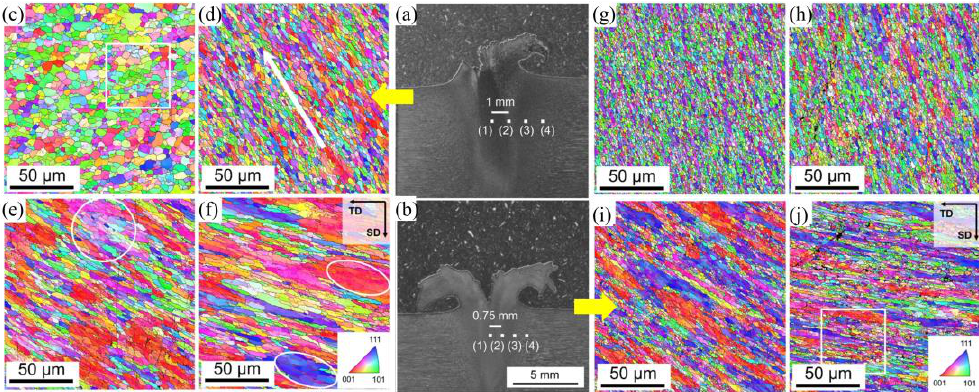
Figure 19. Detail of the microstructure friction welded samples: Overview of ( a ) Mo; overview of ( b ) TZM; ( c ) zone (1) of panel ( a ); ( d ) zone (2) of panel (a); ( e ) zone (3) of panel ( a ); ( f ) zone (4) of panel ( a ); ( g ) zone (1) of panel ( b ); ( h ) zone (2) of panel ( b ); ( i ) zone (3) of panel ( b ); ( j ) zone (4) of panel ( b ). [48].